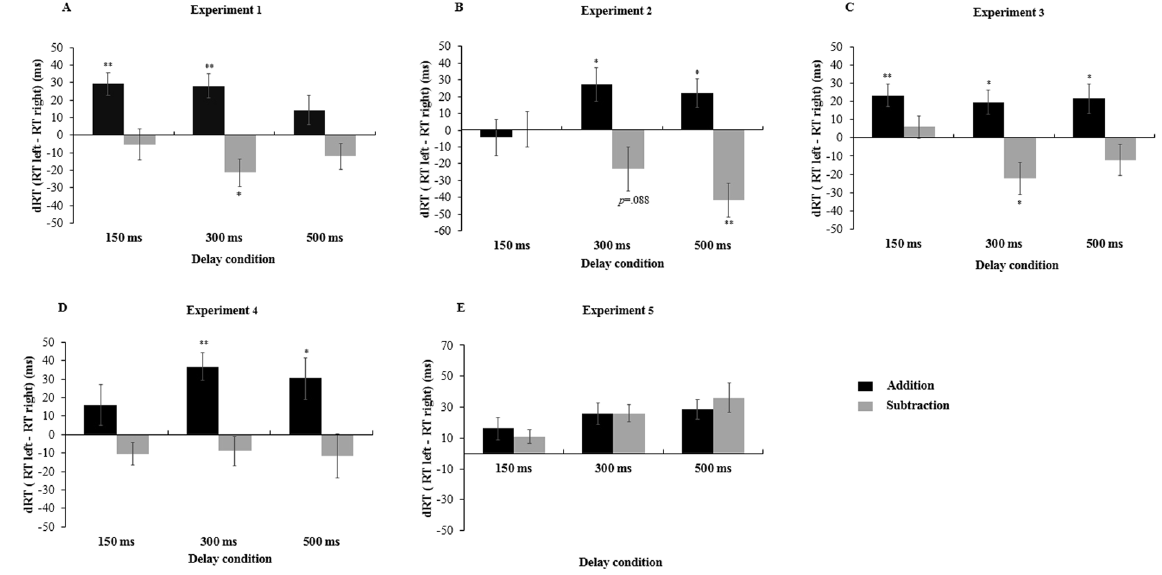
Figure 2. The difference in RT (dRT) as a function of operation (addition or subtraction) with 150 ms, 300 ms, and 500 ms delay in the five experiments. dRT, the mean RT of trials in which target appeared on the left, subtracted from the mean RT of trials in which target appeared on the right, is shown on the vertical axis. “Up” means “right faster”, while “down” means “left faster”. Error bars represent standard error of the mean (SEM). * p < 0.05, ** p < 0.01. Here and elsewhere, data for the target detection task only are shown (see main